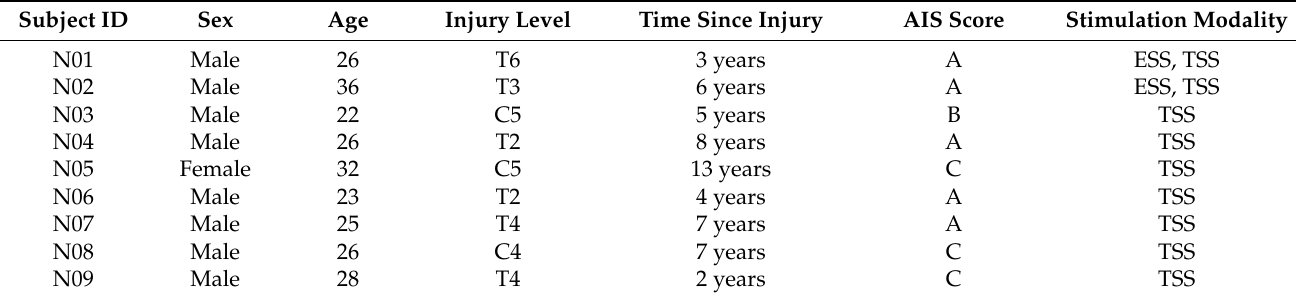
Table 1. Study Participant